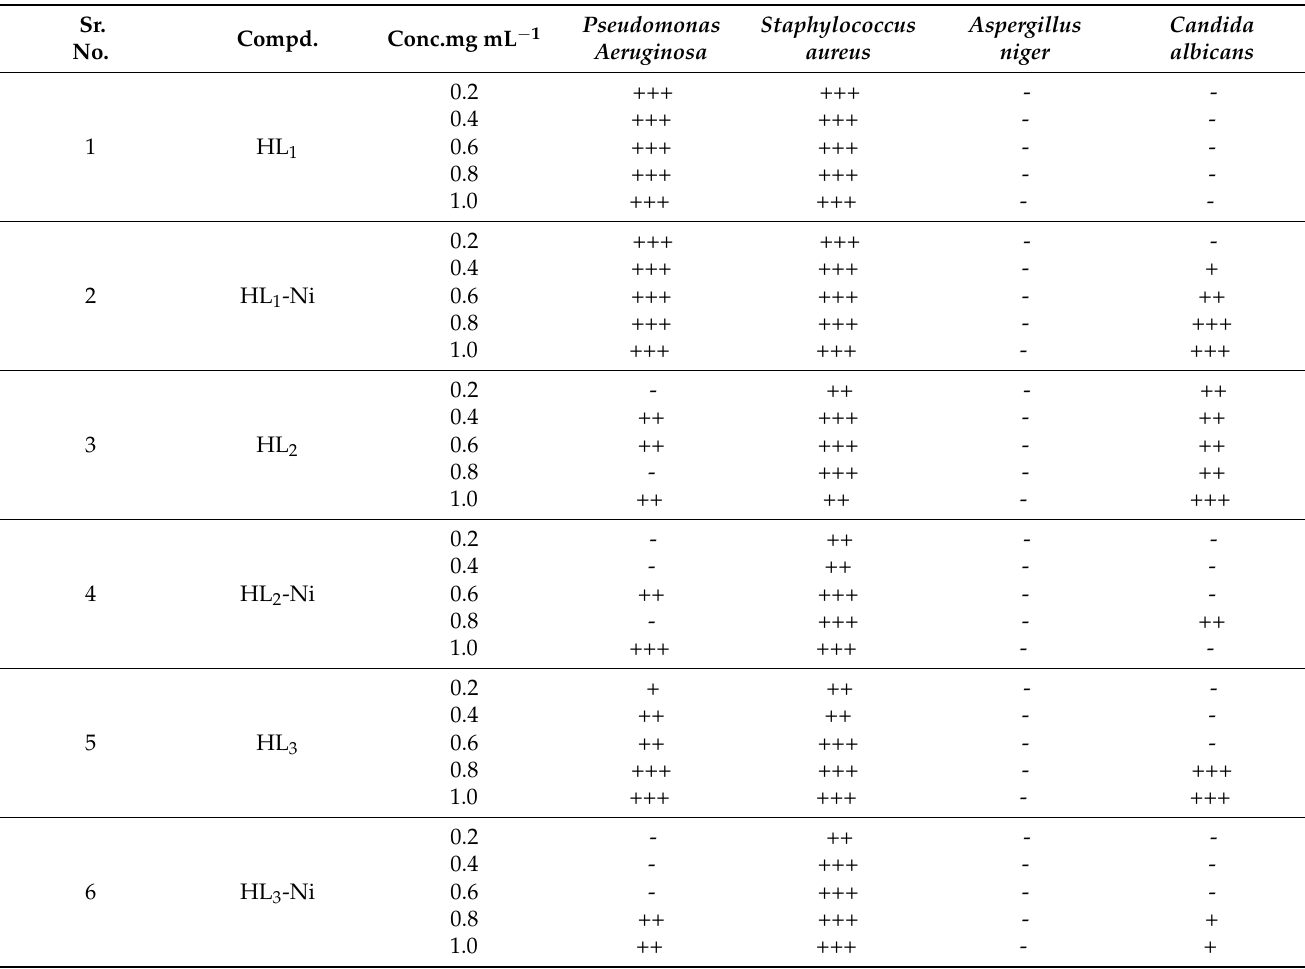
Table 8. Antimicrobial activity of Schiff bases and their Ni(II) complexes.